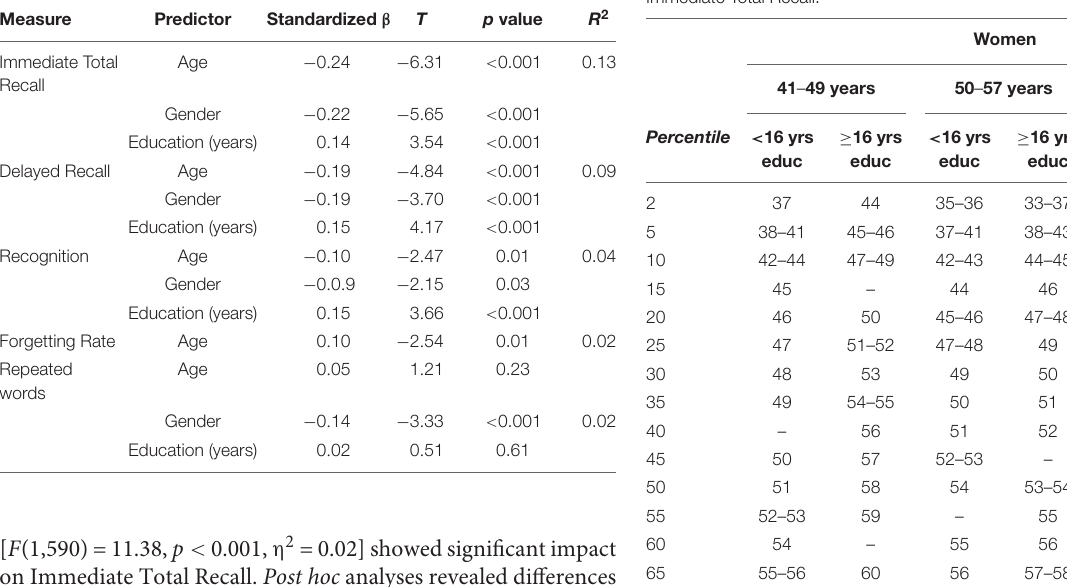
TABLE 5 | Contribution of age, gender, and education on RAVLT scores. TABLE 6 | Normative data for women performance on RAVLT